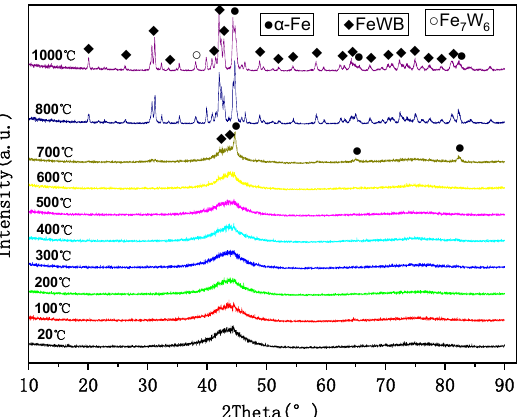
Figure 4. XRD patterns of FeWB amorphous powder processed by annealing at different temperatures. The thermal stability of Fe-W-B amorphous powder was investigated by DSC, and the DSC curves of as-atomized and annealed Fe-W-B amorphous powder are shown in Figure 5. The DSC traces exhibit exothermic reactions corresponding to the crystallization of Fe-W-B amorphous powder as atomized. It shows a two-step process for the crystallization of amorphous structure. The first crystallization temperature (T x1 ) of Fe-W-B amorphous powder is determined to be 607.73 ◦ C, and the second crystallization temperature (T x2 ) is determined to be 805.01 ◦ C. After annealing at 800 ◦ C or 1000 ◦ C, the DSC curves show no exothermic reactions because Fe-W-B amorphous powder has completed the crystallization process, which is also consistent with the previous XRD analysis.